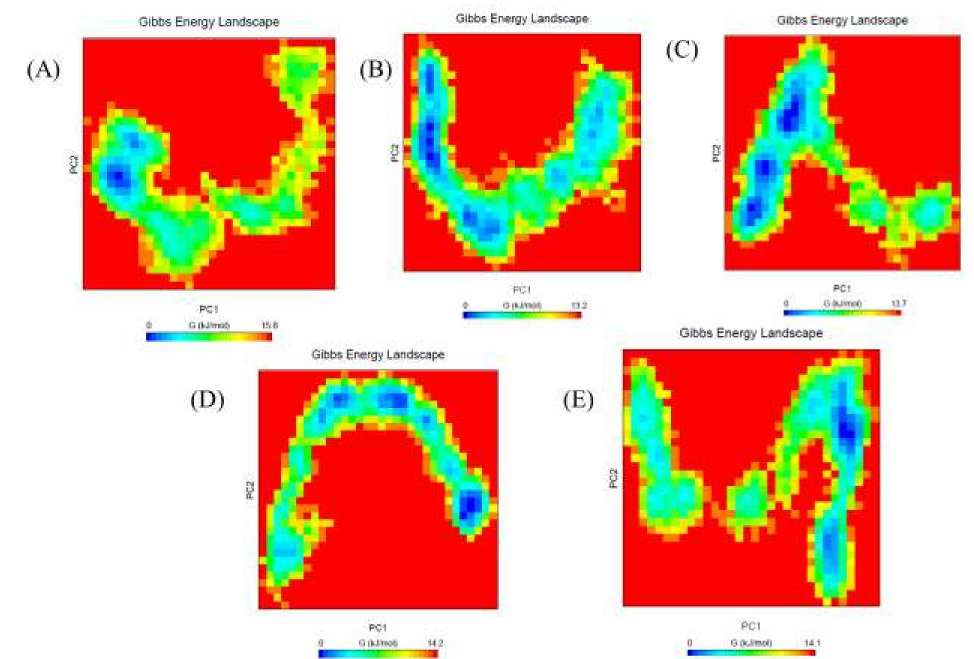
Figure 10. The Gibbs free energy landscape. The Gibbs free energy landscape plot obtained during 100 ns MD simulations for ( A ) Mrlip1, ( B ) Mrlip1-RHC80267, ( C ) Mrlip1-ZINC85530919, ( D ) Mrlip1- ZINC95914464, and (E) Mrlip1-ZINC85530320 respectively.